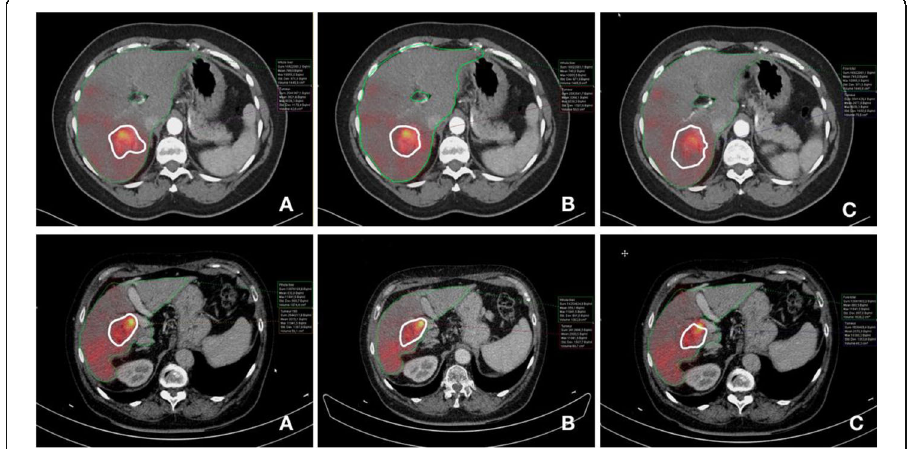
Fig. 5 Example of tumor volume delineation in two patients. A , B , and C are the observers. The upper row shows a tumor with differences in the contouring of the volume, whereas the differences are more limited in the patient represented in the lower